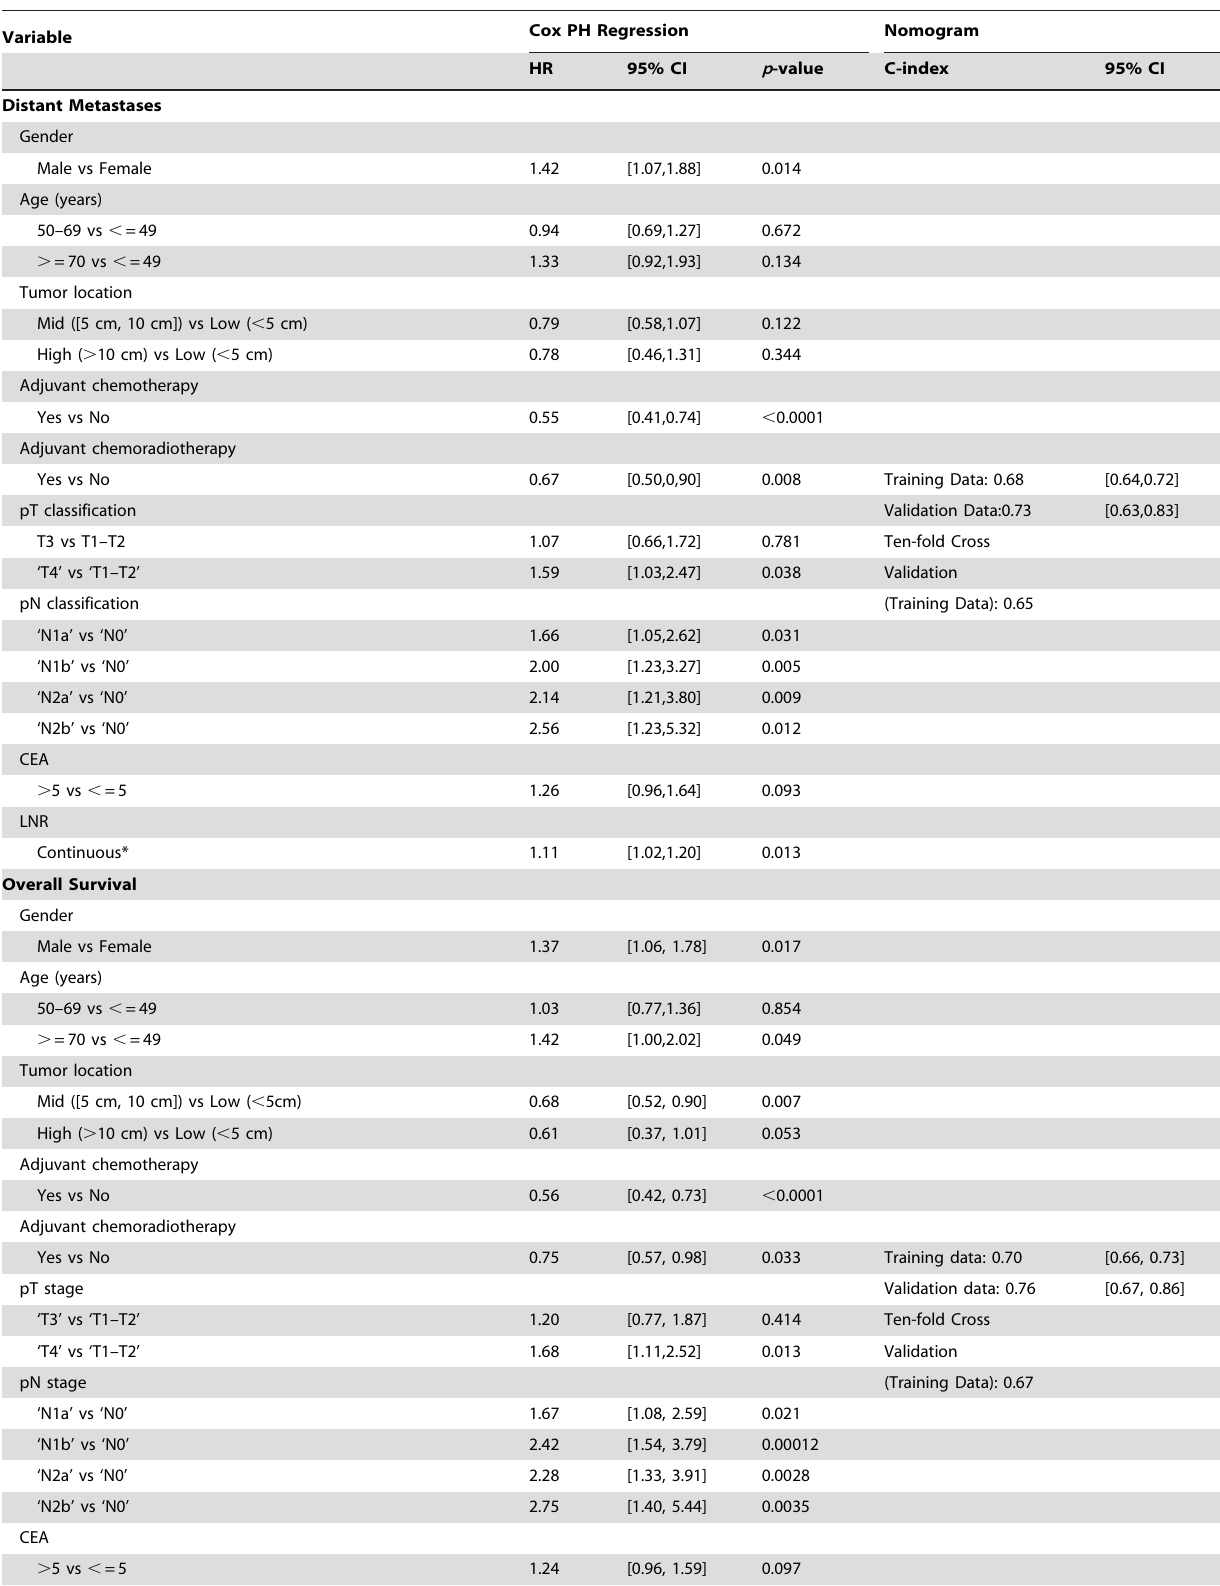
Table 2. Multivariate analyses of 5-year outcomes: the final predictors for developing the nomograms.